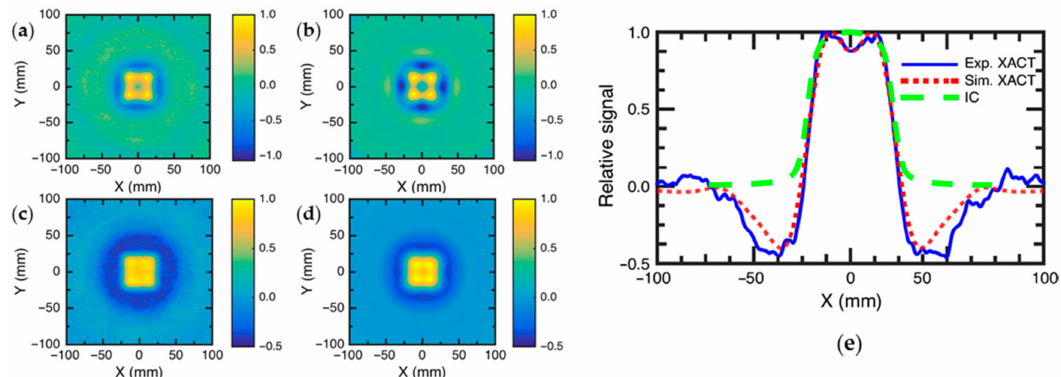
Figure 6. XTA imaging of radiation dose in ( a ) experiment and ( b ) simulation at a depth of 2.4 cm. XTA imaging of radiation dose in ( c ) experiment and ( d ) simulation at a depth of 10 cm; ( e ) thermodose profile estimated by simulation, experiment and ion chamber. Reprinted with permission from